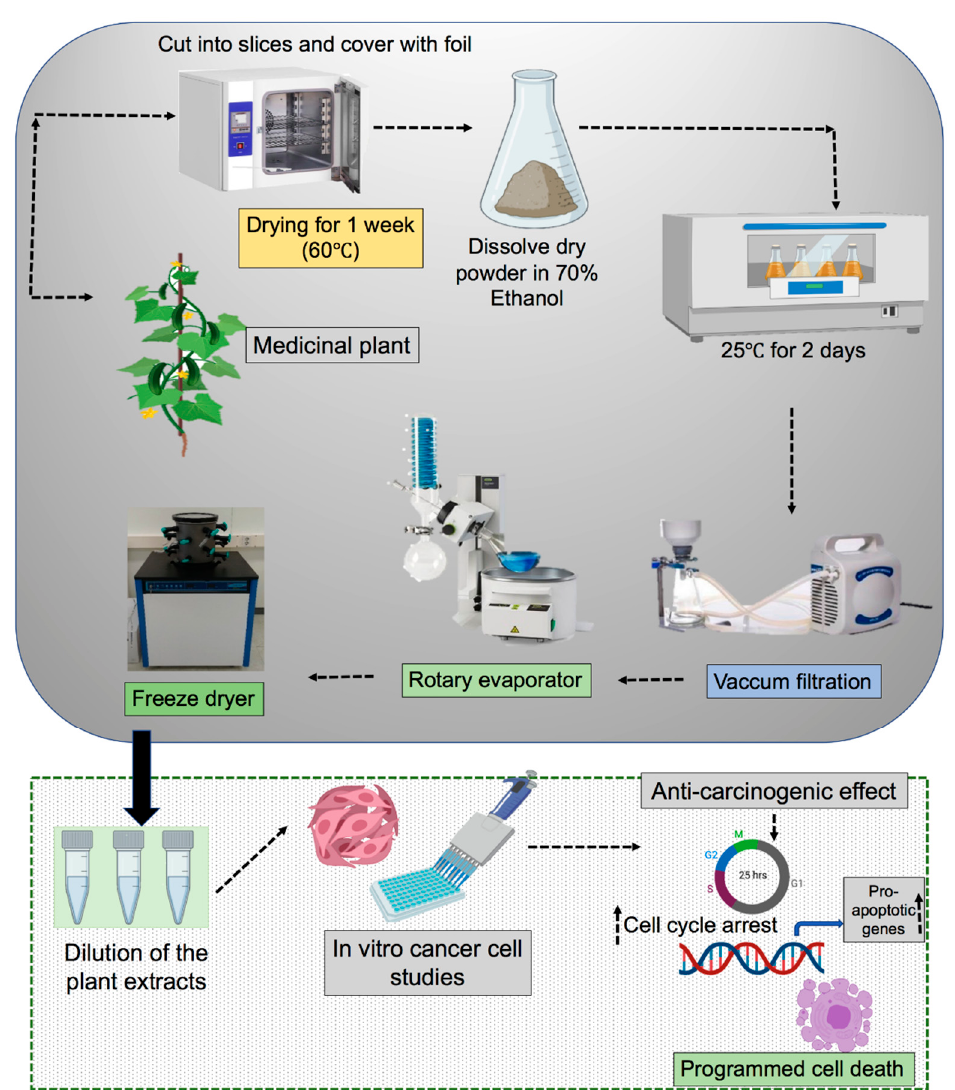
Figure 1. Schematic illustrations of the extract preparation using various medicinal plants and the cancer cell experimental protocol.